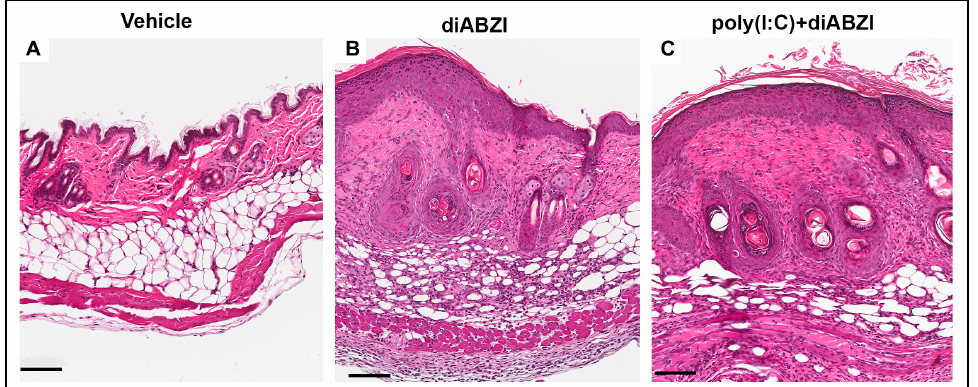
Figure 3. Histopathology of skin lesions at the peak of inflammation. Hematoxylin and eosin-stained photomicrographs of skin collected from the site of injection on day 11, at the peak of inflammation. ( A ) The skin appeared normal in vehicle-treated mice. ( B ) Skin in the margins of the ulcer showed epidermal thickening, dermal inflammation, and fibrosis in mice injected with diABZI and ( C ) poly (I:C)+diABZI (scale bar = 100 µm).